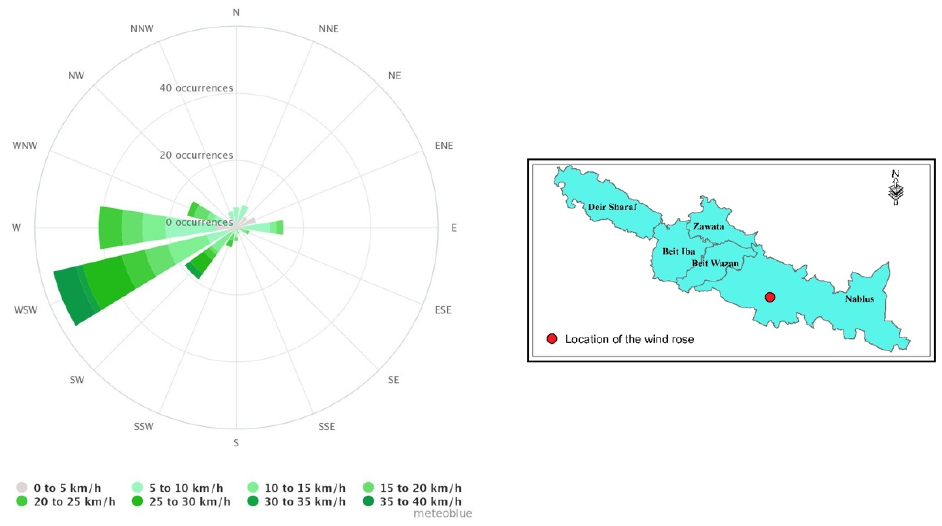
Figure 3. Wind rose of Nablus (Meteoblue).